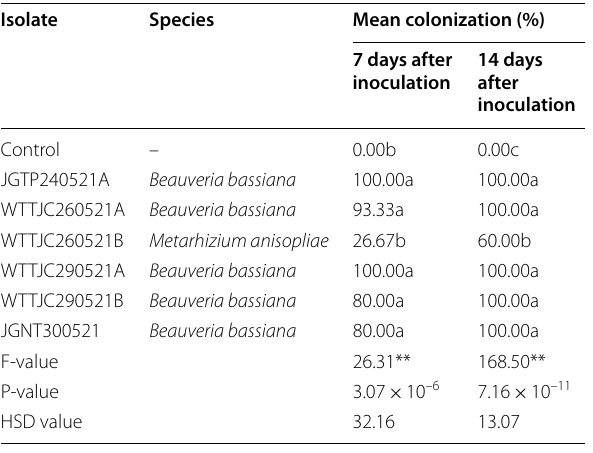
Table 2 Effect of fungal isolates on mean colonization (%) or percentage of leaves colonized by endophytic entomopathogenic fungi at 7 and 14 days after inoculation